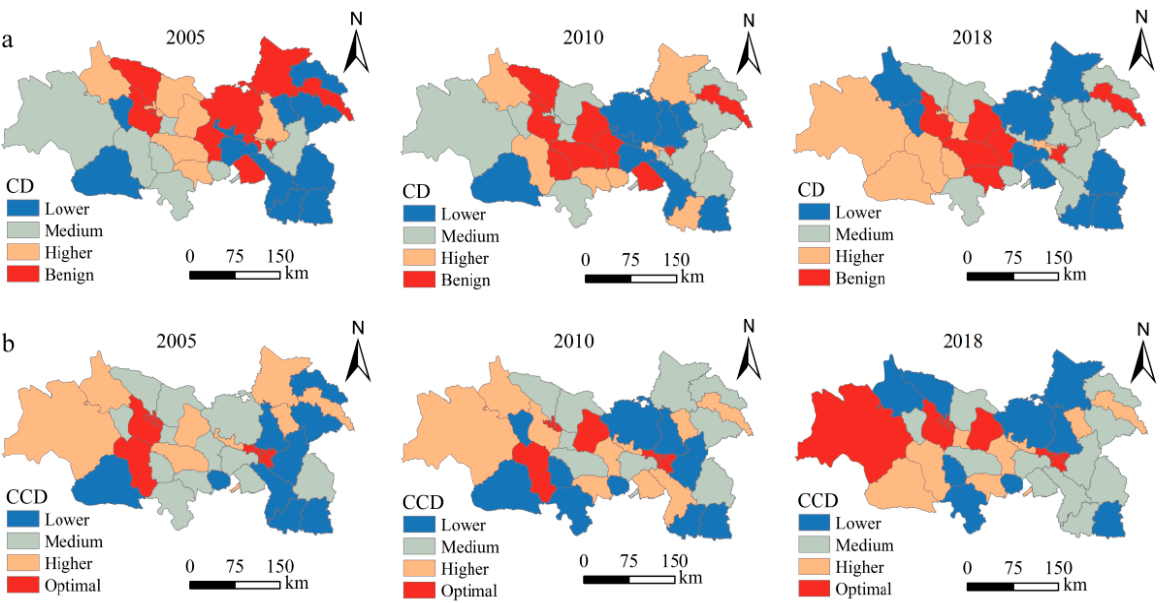
Figure 6. Spatial differentiation of the CD and CCD of social, economic, and eco-environmental benefits of construction land use in LXUA. ( a ) Coupling degree, ( b ) Coupling coordination degree.